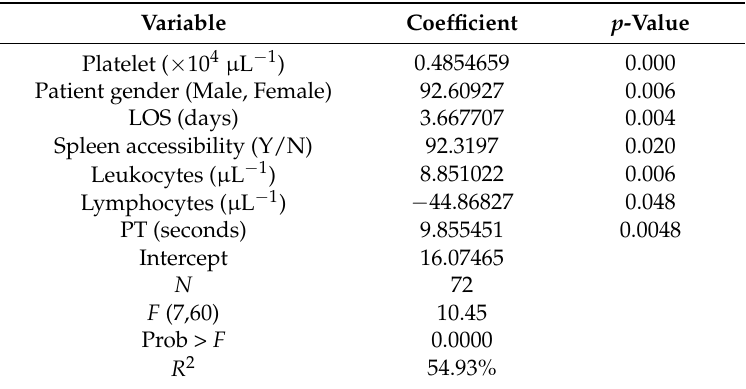
Table 1. Restricted multiple linear